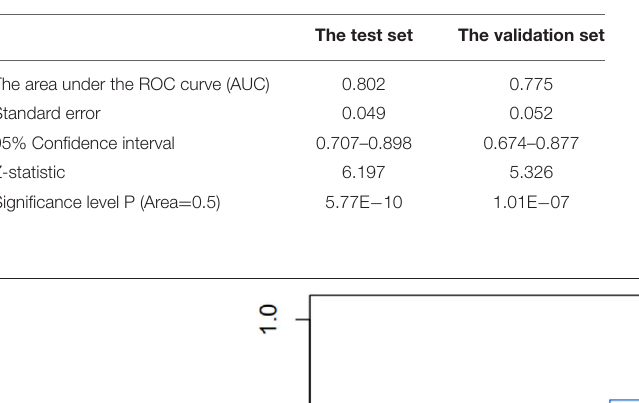
Frontiers in Public Health |